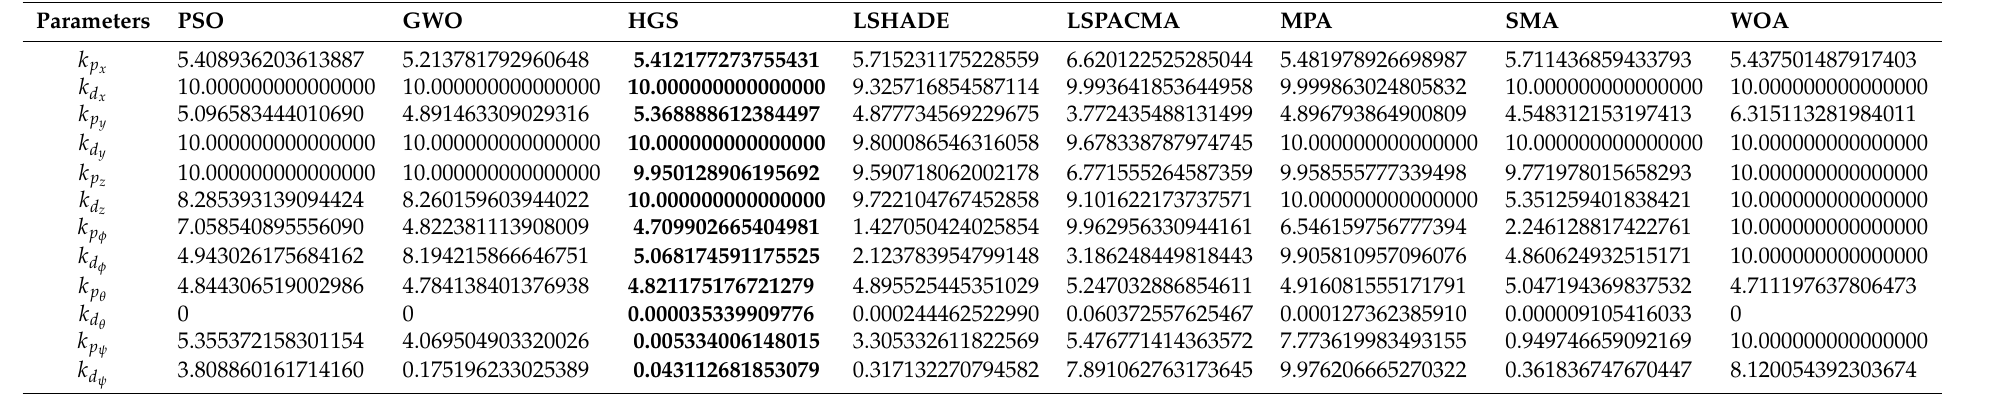
Table 2. The parameter estimation of metaheuristic algorithms with 20 individuals, 20 evolutions and 30 repetitions